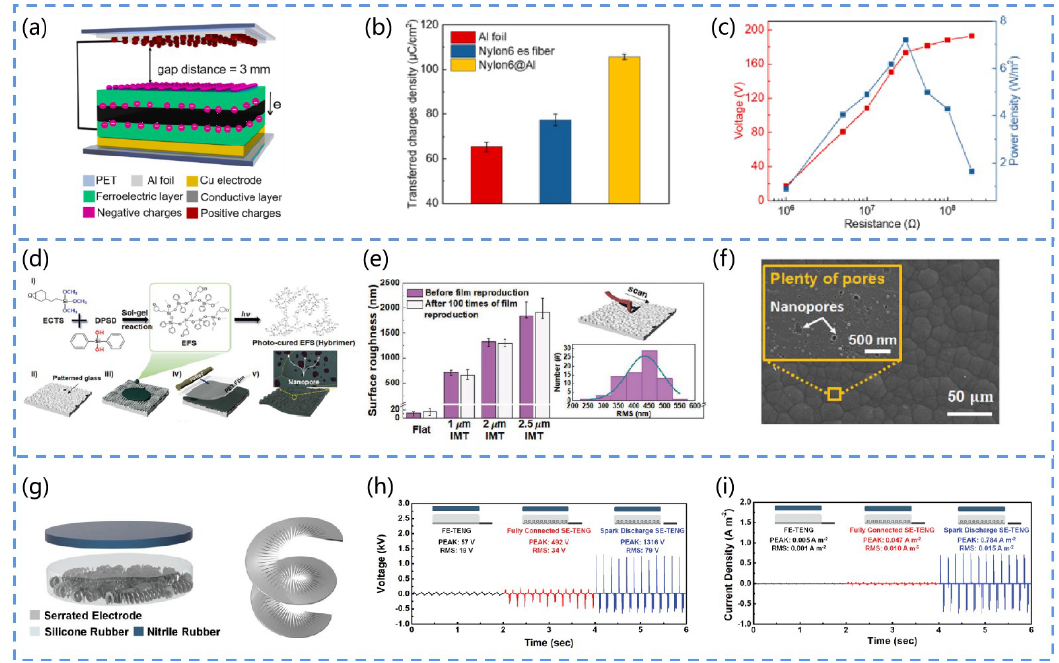
Figure 5. ( a ) Schematic diagram of the structure of the TENG. ( b ) Transfer charge density of the TENG. ( c ) The output power of the optimized TENG. Reprinted from [49] with permission from Elsevier. ( d ) The manufacturing process of SGH membranes. ( e ) Surface roughness of SGH films before and after 100 replications. ( f ) SEM image of the SGH film. Reprinted from [50] with permission from Wiley Online Library. ( g ) Schematic diagram of the structure of the electrode. ( h ) The voltage of the TENG and ( i ) the current density of the TENG. Reprinted from [51] with permission from Wiley Online Library.